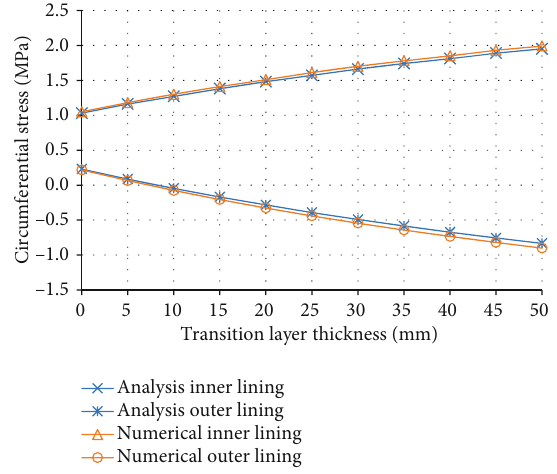
Figure 10: Circumferential stress at inner radius of inner and outer linings with di ff erent thickness of transition layer. Table 4: Calculation parameter